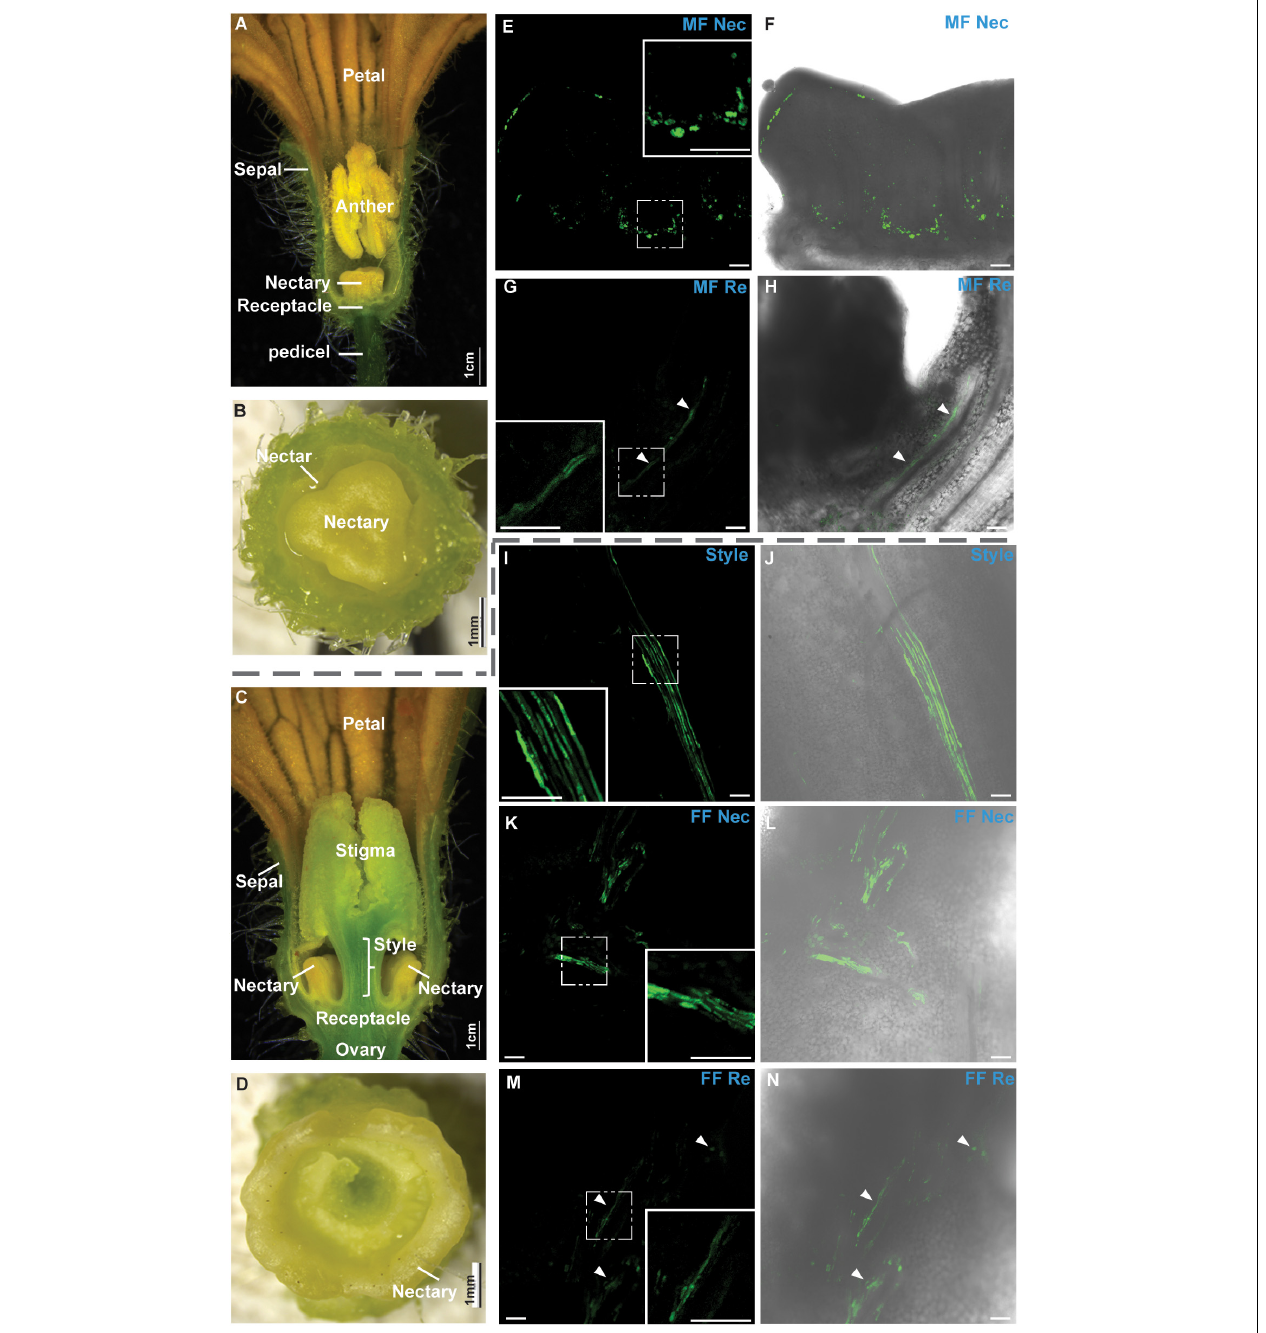
FIGURE 1 | Microscopic images of cucumber flowers at anthesis. (A–D) Medial longitudinal (A,C) and transverse anatomy images (B,D) of male (A,B) and female flowers (C,D) at anthesis. (E–N) Confocal laser scanning microscopy (CLSM) of carboxyfluorescein (CF) unloading from the phloem was shown in male (E–H) and female flowers (I–N) . CF signal was labeled in green in male and female flowers 6 h after feeding carboxyfluorescein diacetate (CFDA) at the leaf. CF signal in nectary (Nec) (E,F) and receptacle (Re) (G,H) of male flower (MF); in style (I,J) , nectary (K,L) , and receptacle (M,N) of the female flower (FF), respectively. The boxed insets in panels (E,G,I,K,M) were the close-up images. Bars in panels (E–N) were 100 µ m. Bars in the close-up images were 50 µ m. White arrows indicate the CF signal.